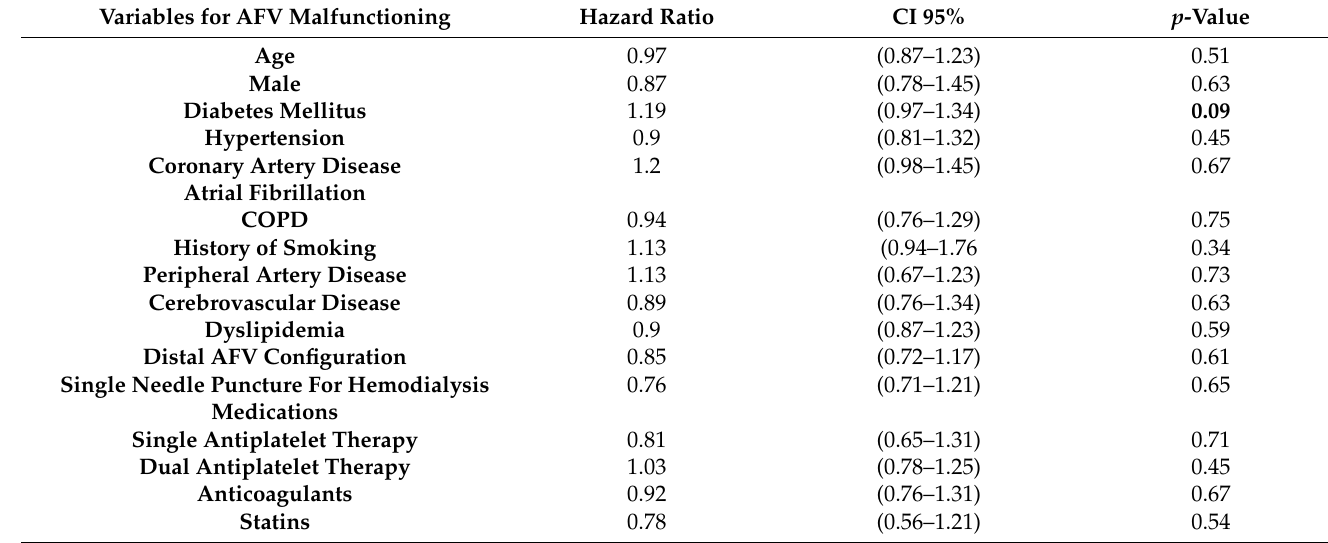
Table 2. Stepwise analysis for the predictors of AVF malfunctioning.